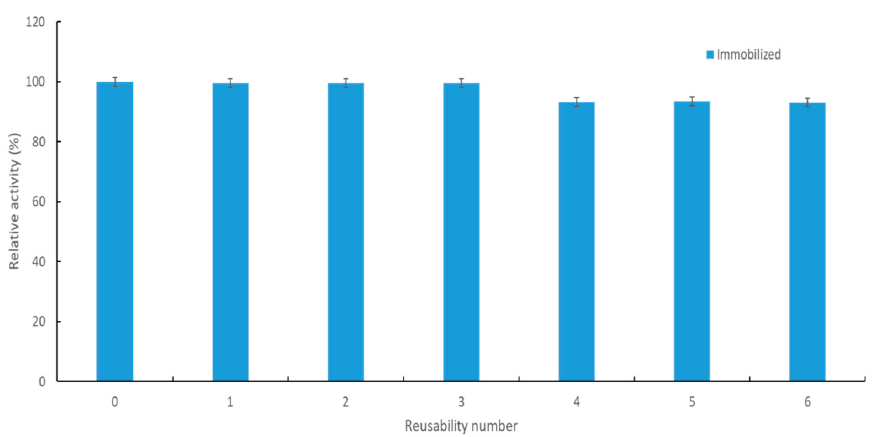
Figure 11. Reusability of immobilized YT PTE.